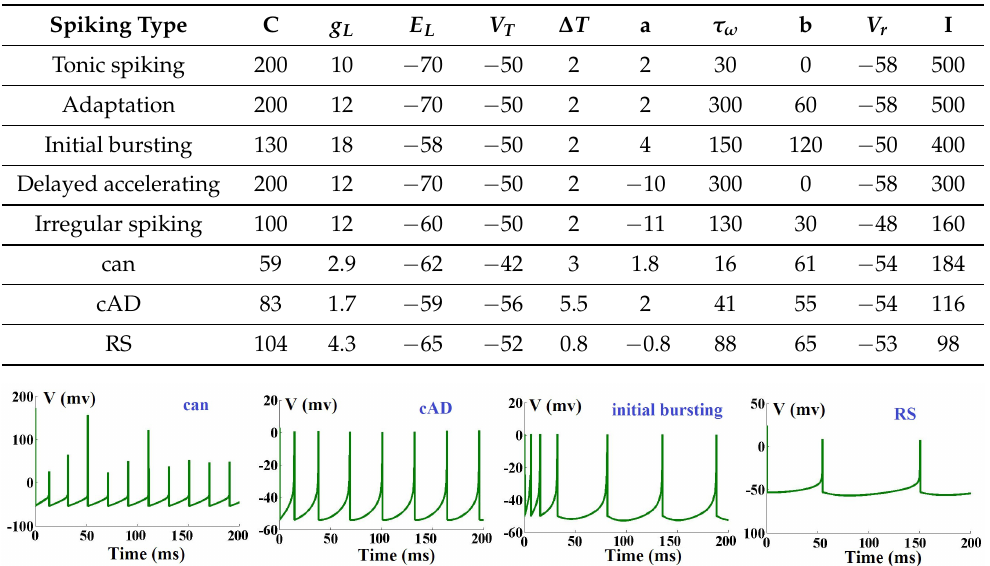
Table 1. ADEX parameters for generating different spiking patterns.